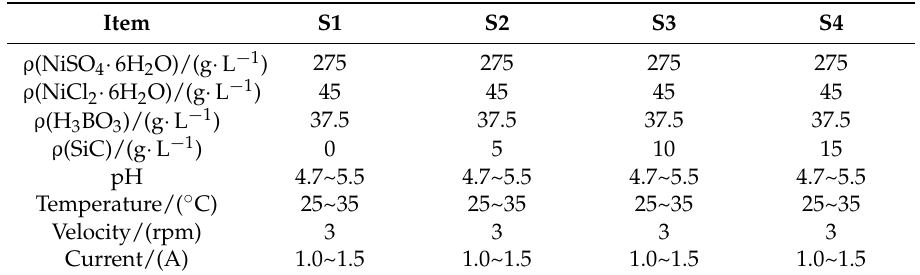
Table 1. Overview of electrodeposition parameters for preparation of pure Ni plated cubic boron nitride (cBN) and Ni/SiC plated